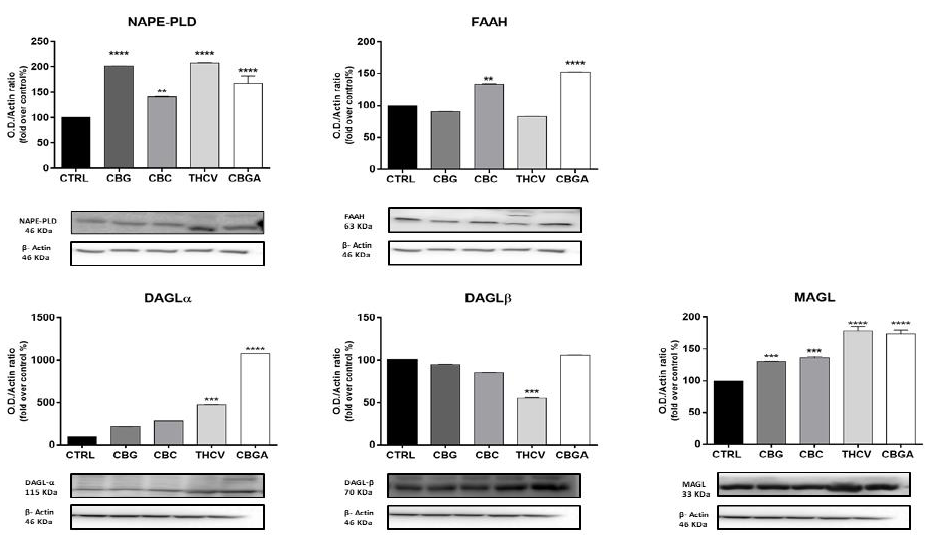
Figure 5. Protein expression of AEA and 2-AG metabolic enzymes (NAPE-PLD, FAAH, DAGL α / β and MAGL) following 24 h of treatment with half-IC 50 amounts of: CBG, CBC, THCV and CBGA. Densitometric analyses of immunoreactive bands were normalized to β -actin as the housekeeping protein and were presented as fold change over control (%). The data are the means ± SEM of three independent experiments ( n = 3). Statistical analysis was performed using a one-way ANOVA test, followed by the Bonferroni post hoc test (** p < 0.01, *** p < 0.001 and **** p < 0.0001 vs. control). The most significant effects of pCBs on the gene and protein expression of ECS elements in HaCaT cells are summarized in Table 2. Table 2. Summary of the most significant effects of half-IC 50 doses of pCBs on ECS elements at the gene and protein levels following HaCaT cell treatment for 24 h. Legend: ↑ significant increase; ↓ significant decrease; + p < 0.05, ++ p < 0.01, +++ p < 0.001 and ++++ p < 0.0001 vs. control.